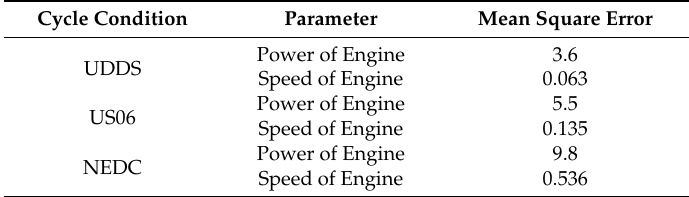
Table 3. Mean square error of obtained data from two control strategies.